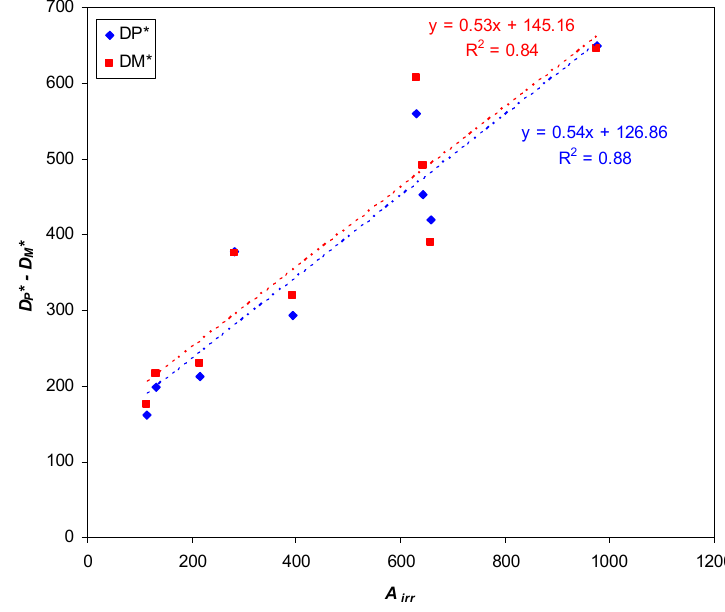
Figure 4. Correlations between the ESHP diameters ( D P * ; D M * ) and the irrigated area ( A irr ) in the SM for evaluating SHP energy production in seven irrigation systems of Calabria (Southern Italy).